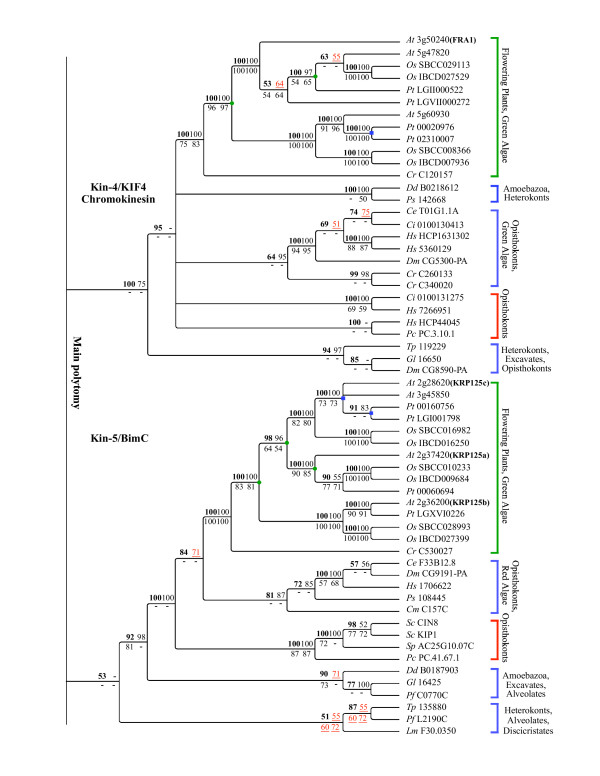
Expanded view of Kinesin-4 and Kinesin-5 families. Expansion of the Kinesin-4 and Kinesin-5 families from Figure 2. Experimentally studied Arabidopsis kinesins are indicated in parenthesis with their published names in bold. Green brackets indicate plant-specific groups, mixed clades are shown in blue brackets and red brackets indicate groupings composed of opisthokonts. Green circles and blue squares indicate gene duplications in flowering plants and dicots, respectively. See Fig. 2 legend for an explanation of support values. For full names of species see Fig. 1 legend.